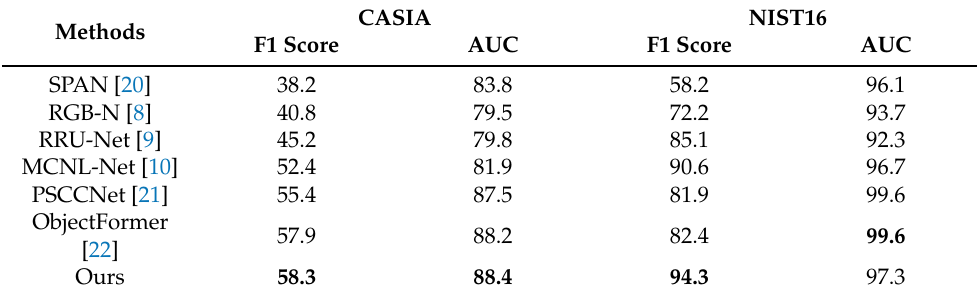
Table 1. The results (%) of the proposed method and the other methods on the testing set. Methods